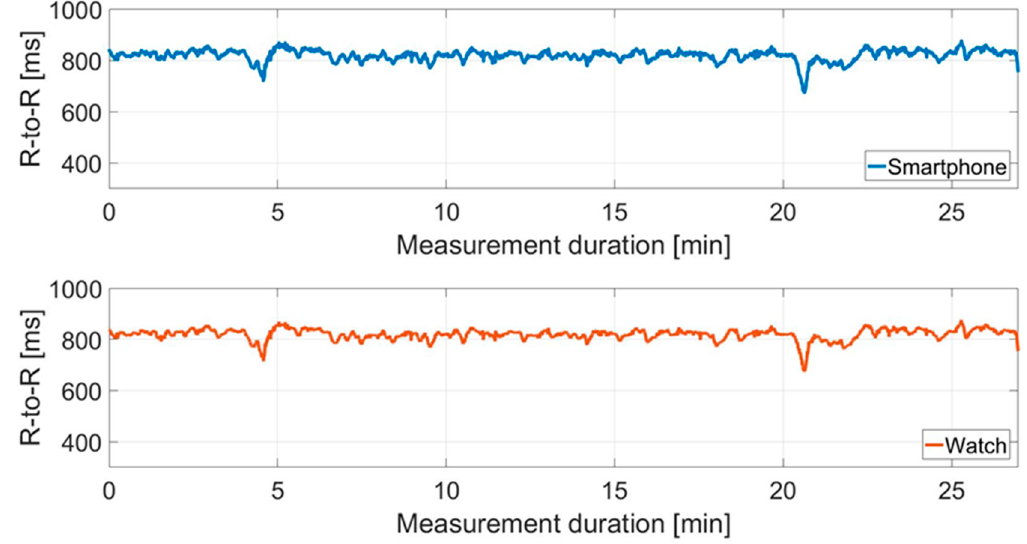
Figure 5. Comparison between the mean RR intervals (R-to-R) (ms) of the two signals in the data set derived from the smartphone IoTool application and the Polar watch V800 for Cow I over the experimental period of 27 min after artifact correction ( n = 3630 measured values).